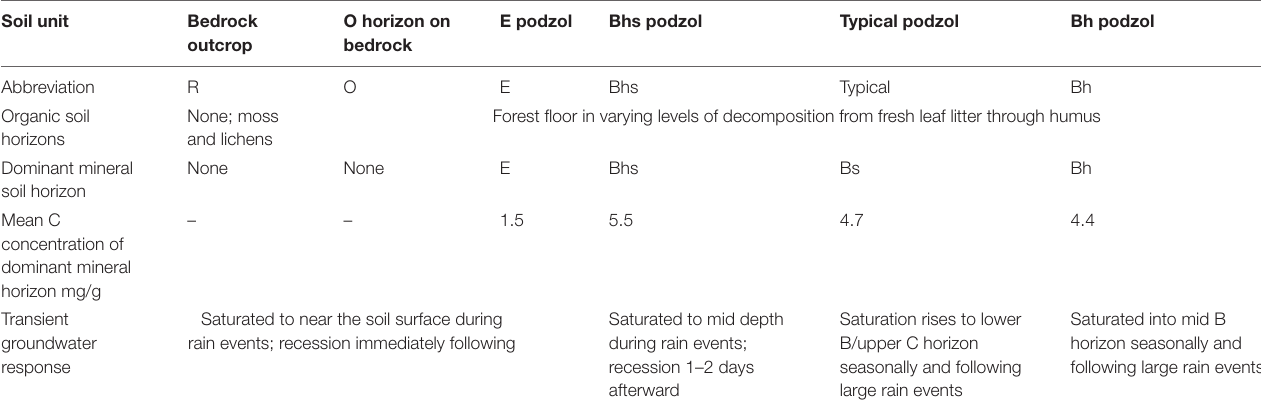
TABLE 1 | Summary of functional soil units showing the dominant horizons, carbon concentration, and general groundwater response in